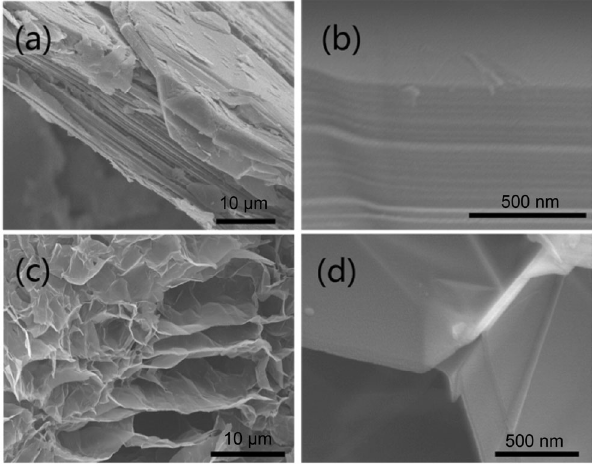
Fig. 2 SEM micrographs of (a–b) NG and (c–d) EG.